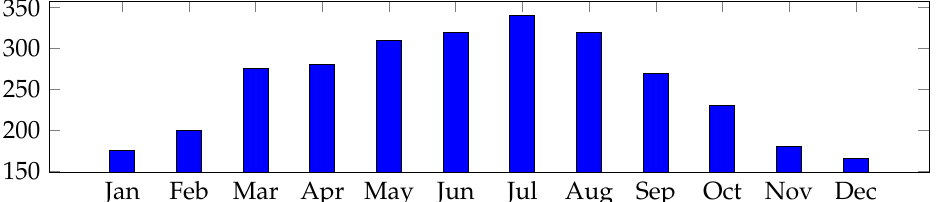
Figure 6. Power generation estimate: average Spanish peninsular in kWh (vertical axis) for each month considering a 1500-W module installed.